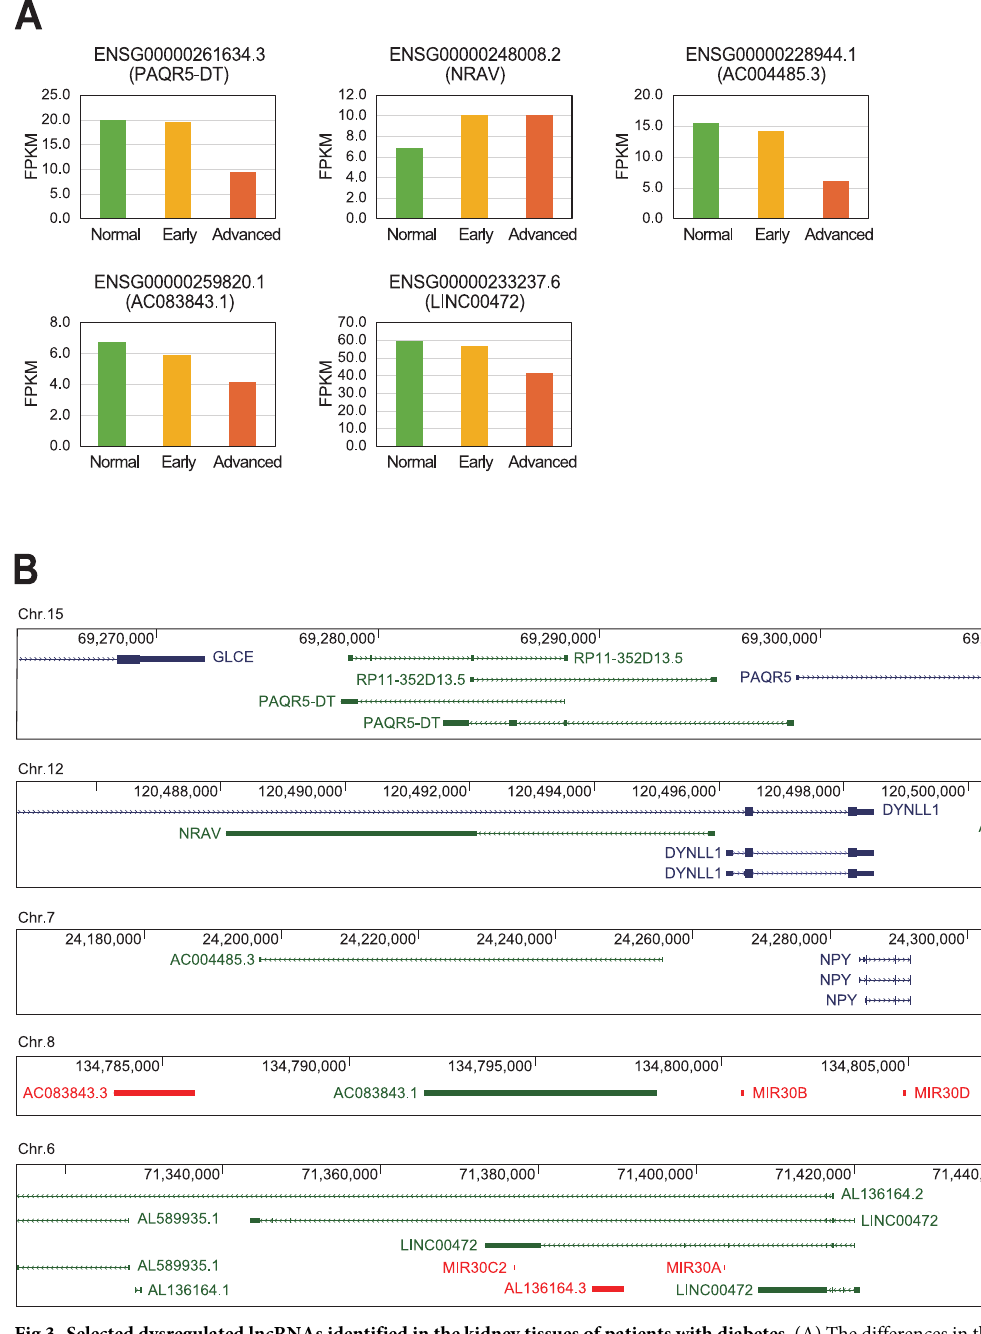
PLOS ONE | https://doi.org/10.1371/journal.pone.0274794 September 26,